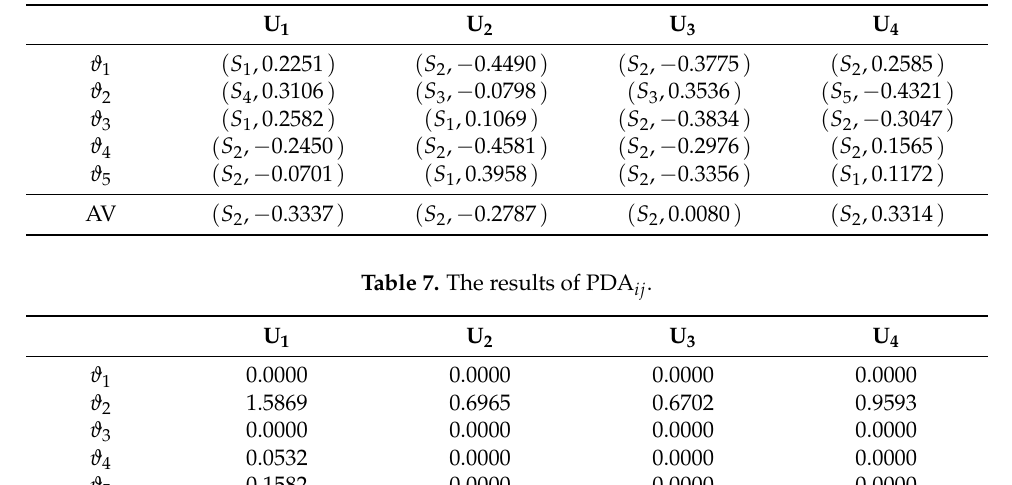
Table 6. The score values of ϑ (cid:48) ij and AV j .